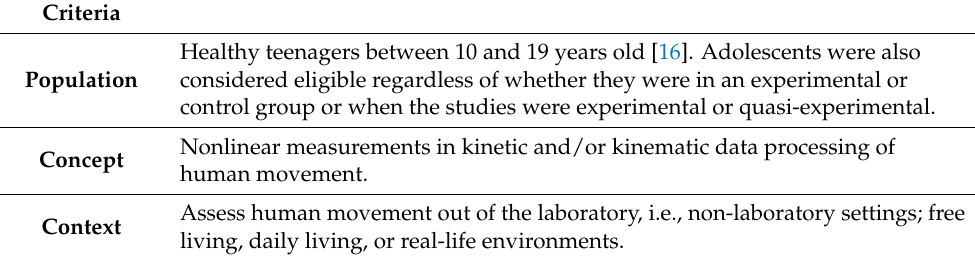
Table 1. Eligibility criteria according to PCC.